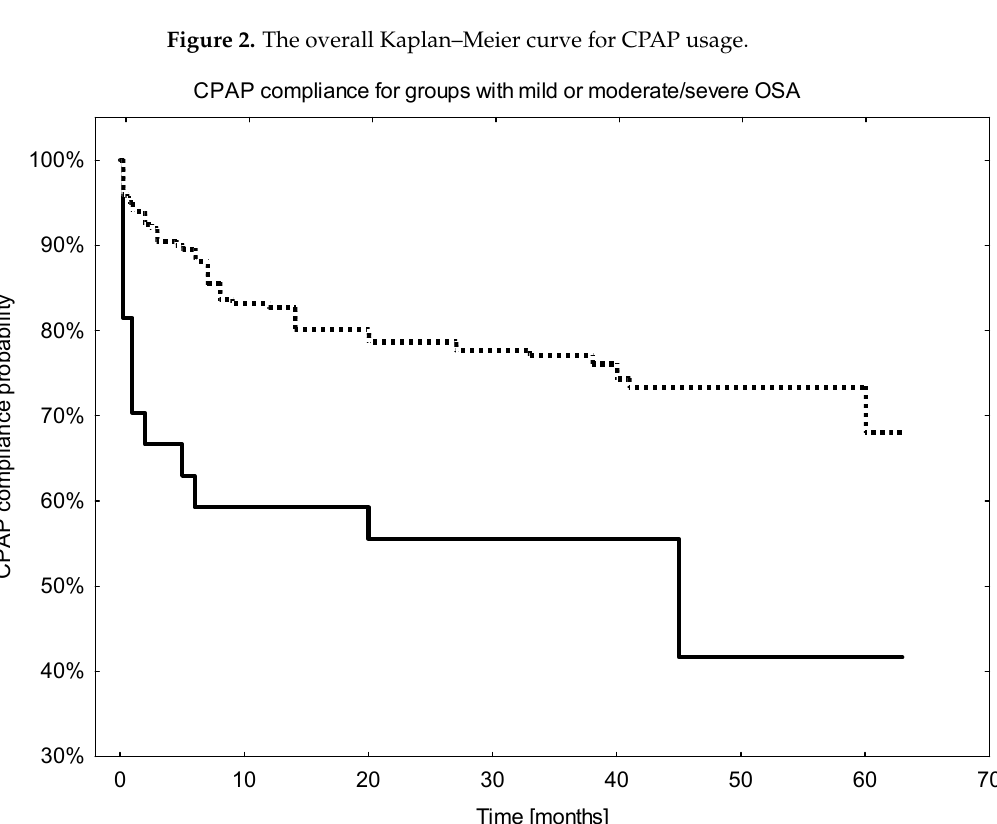
Figure 3. The Kaplan–Meier curves for CPAP usage calculated for groups of patients with moderate or severe OSA (AHI ≥ 15) and mild OSA (AHI < 15). solid line—patients with AHI < 15, dotted line—patients with AHI ≥ 15.